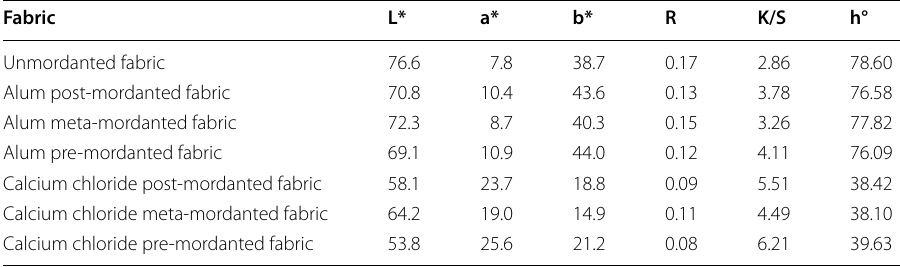
Table 3 CELab coordinate system and colour